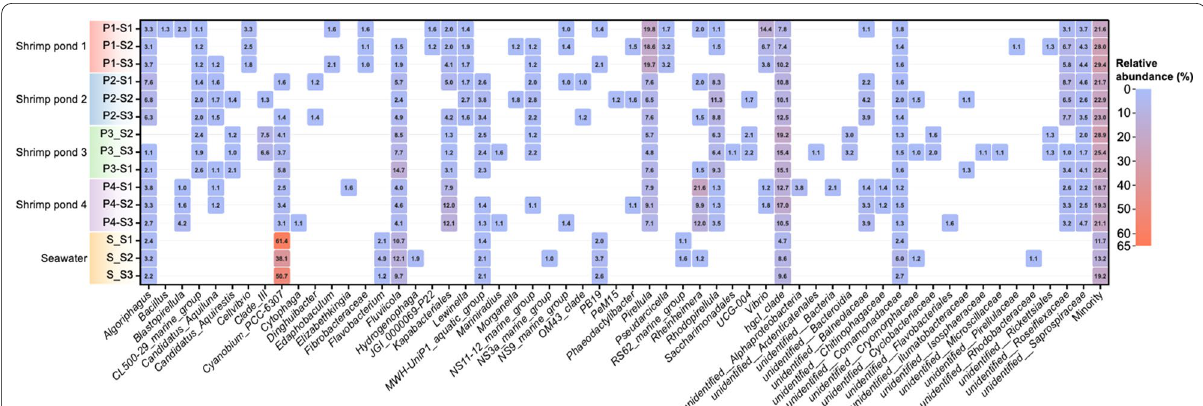
Fig. 2 Heatmap showing relative abundance and community compositions of bacterial genera in shrimp ponds and seawater samples. The genus-level distribution is based on the 97% similarity clusters OTUs. Sequences whose relative abundance was lower than 1% were assigned as “Minority”